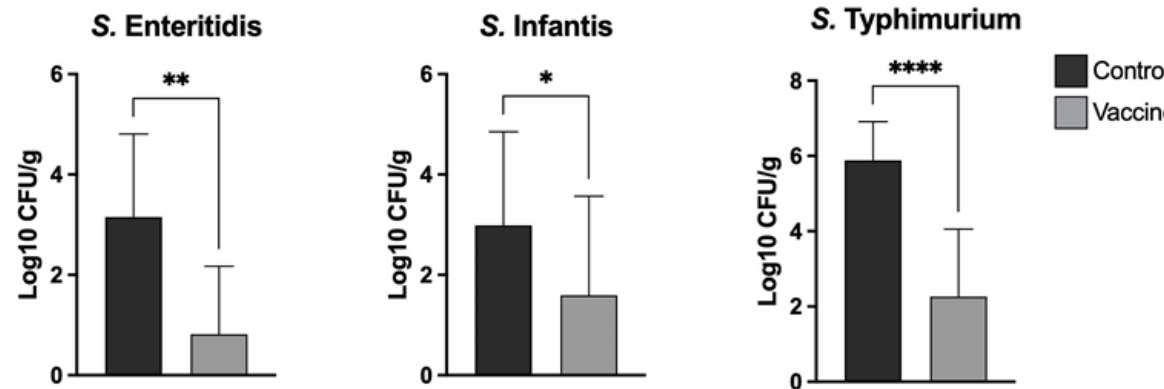
Figure 3. Efficacy of vaccination in reducing bacterial. Chickens were orally challenged at 10 weeks of age with 10 9 CFU of each Salmonella serotype and seven days later, the challenged serotype was quantified via plate culture in the cecum. Data show mean ± SD of 14 chickens per group. An unpaired t -test was performed; asterisks show statistical significance: * p ≤ 0.05, ** p ≤ 0.01, **** p ≤ 0.0001.